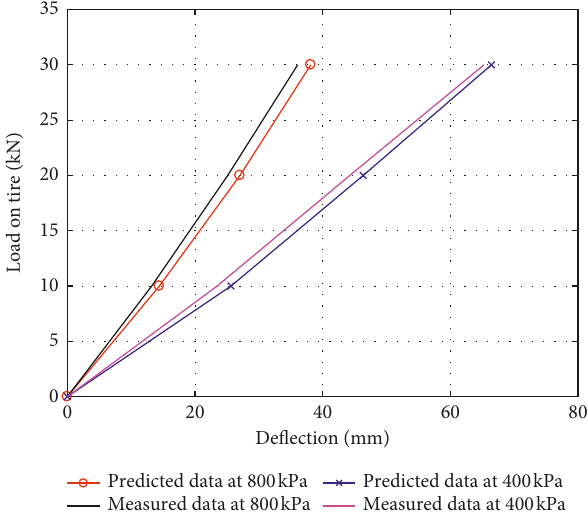
Figure 3: Comparison of the predicted load-deformation data with the measured